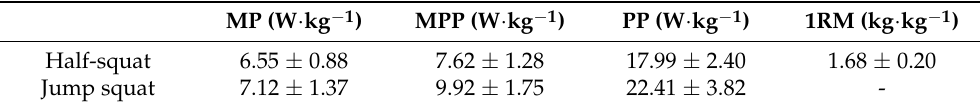
Table 2. Descriptive data (mean ± standard deviation) of the bar-power outputs and one repetition maximum (1RM) in the half-squat and jump squat exercises.